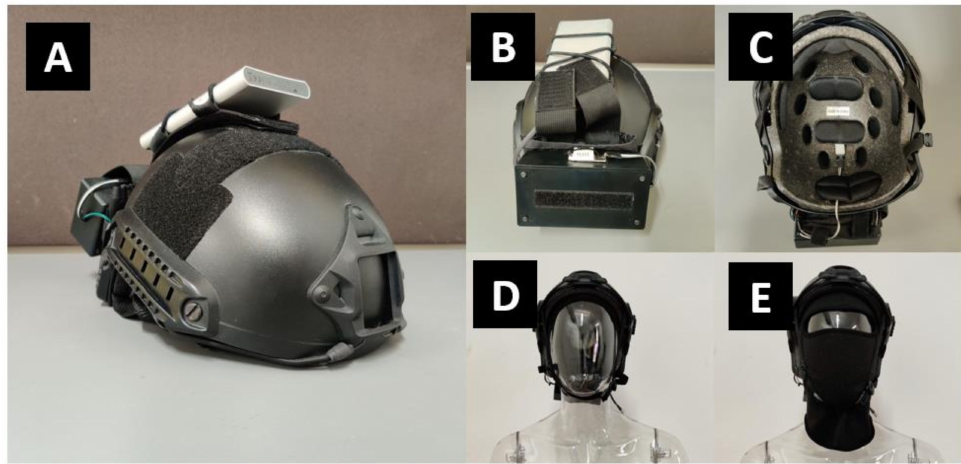
Figure 2. Photos of prototype of Future Assault Shell Technology (FAST) style helmet. ( A ) Isometric view; ( B ) rear view with datalogger and ambient sensor; ( C ) internal view with microclimate sensor location; ( D ) prototype on mannequin head without a mask; ( E ) prototype on mannequin head with a balaclava